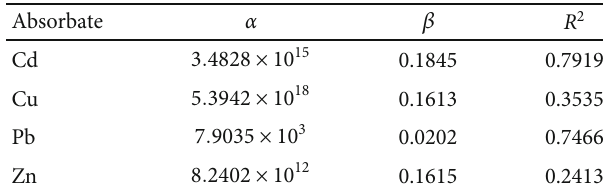
Table 2: Fitting parameters of Elovich model.